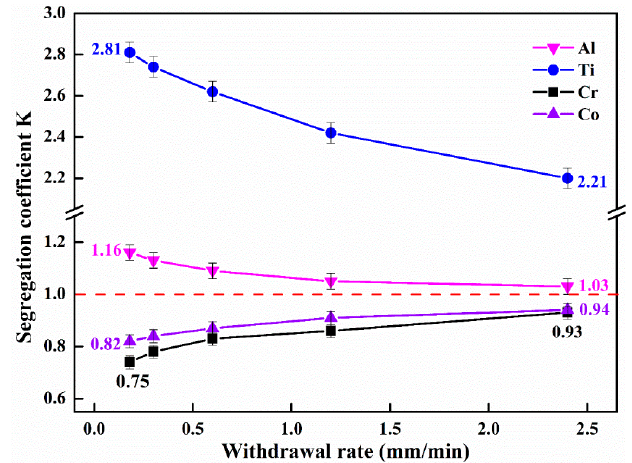
Figure 6. Segregation of elements in GH4720Li superalloy at different withdrawal rates.